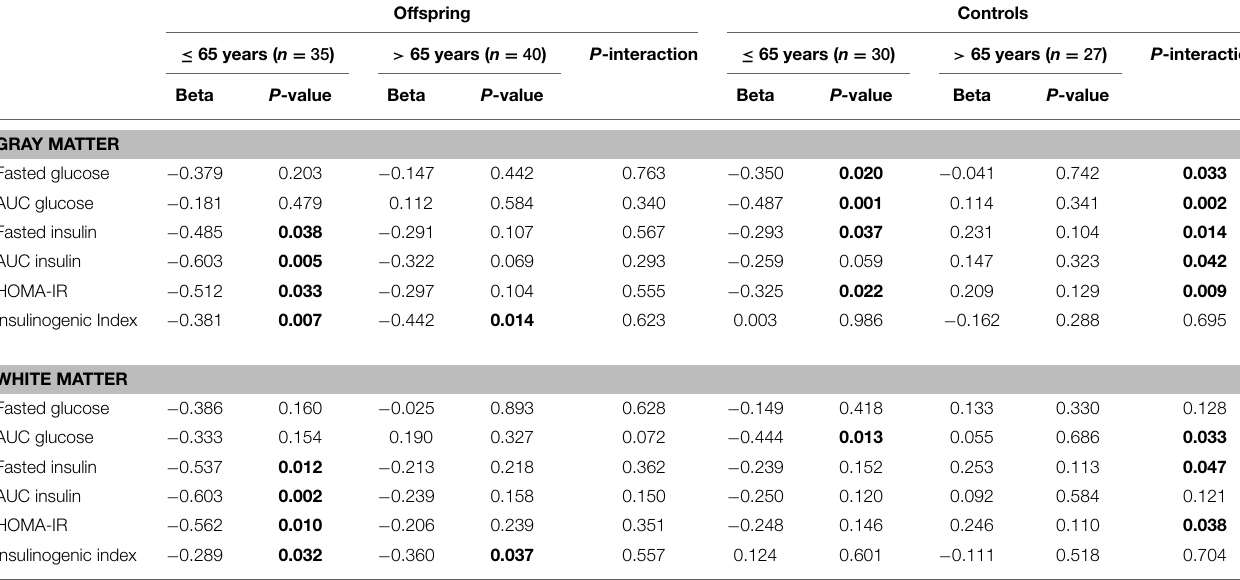
TABLE 3 | Association of MTR peak height with markers of glucose metabolism in “younger” and “older” offspring and controls. Offspring